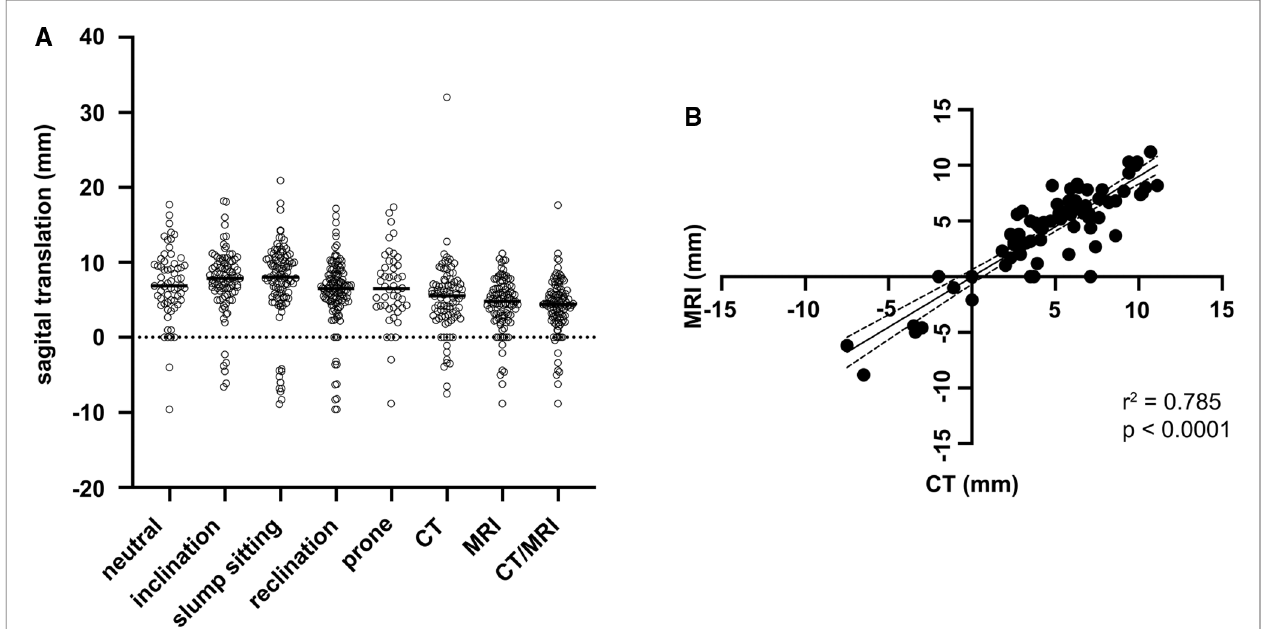
FIGURE 2 | Mean sagittal translation for every imaging modality ( A ) and Correlation of sagittal translation between CT and MRI ( B ).